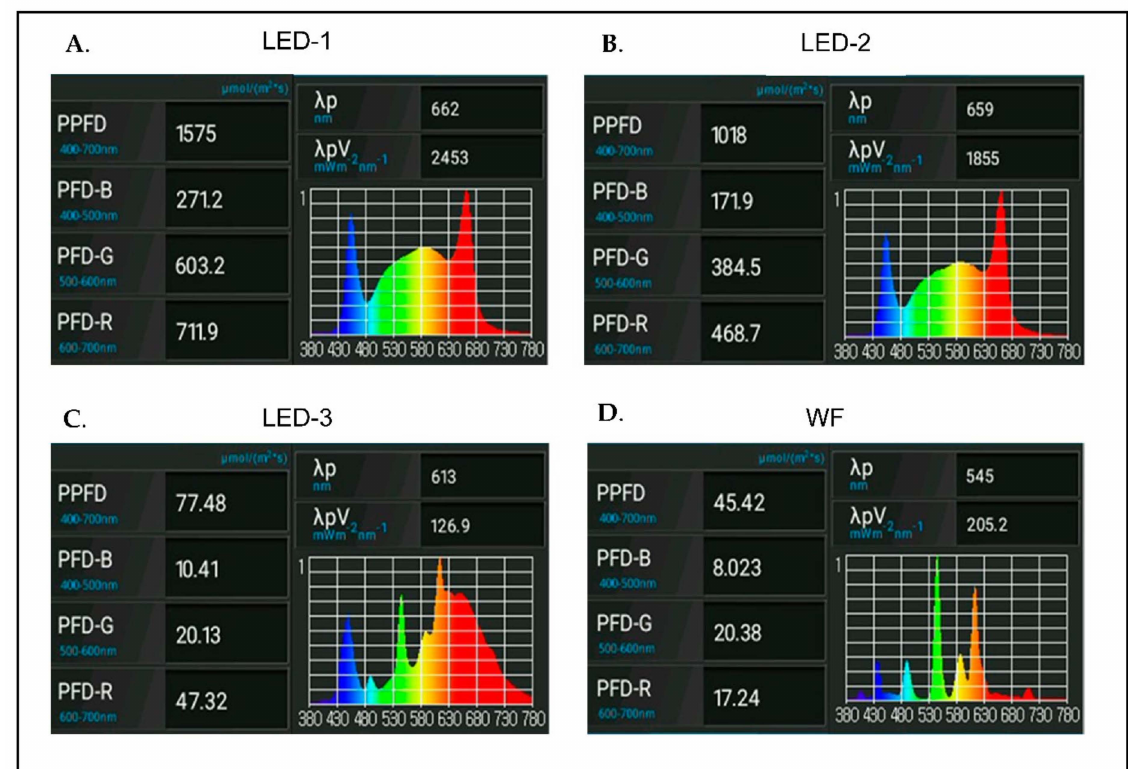
Figure 1. Intensity and composition of light-emitting diodes (LED) and white fluorescent (WF) light sources evaluated for the micropropagation of Brassavola nodosa in this experiment: ( A ) LED-1 = 1575 ± 50 µ mol m − 2 s − 1 PPFD consisting of 17% blue light ( B ) at 400–500 nm, 38% green light (G) at 500–600 nm, and 45% red light (R) at 600–700 nm; ( B ) LED-2: LED light with with 80 ± 5 µ mol m − 2 s − 1 PPFD consisting of 13% B, 26% G, and 61% R; and ( D ) WF: white fluores- cent with 50 ± 5 µ mol m − 2 s − 1 PPFD consisting of 17% B, 45% G, and 38% R. Measurements were obtained with an LI-180 Li-Cor